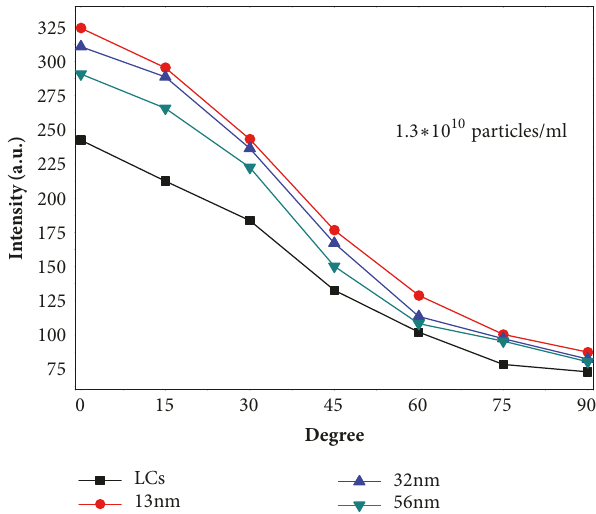
Figure 5: The peak intensity of PL emissions of pure NLCs and doping GNPs versus the rotational degree of NLCs’ director, where the concentration of GNPs is 1.3 ∗ 10 10 particles/ml